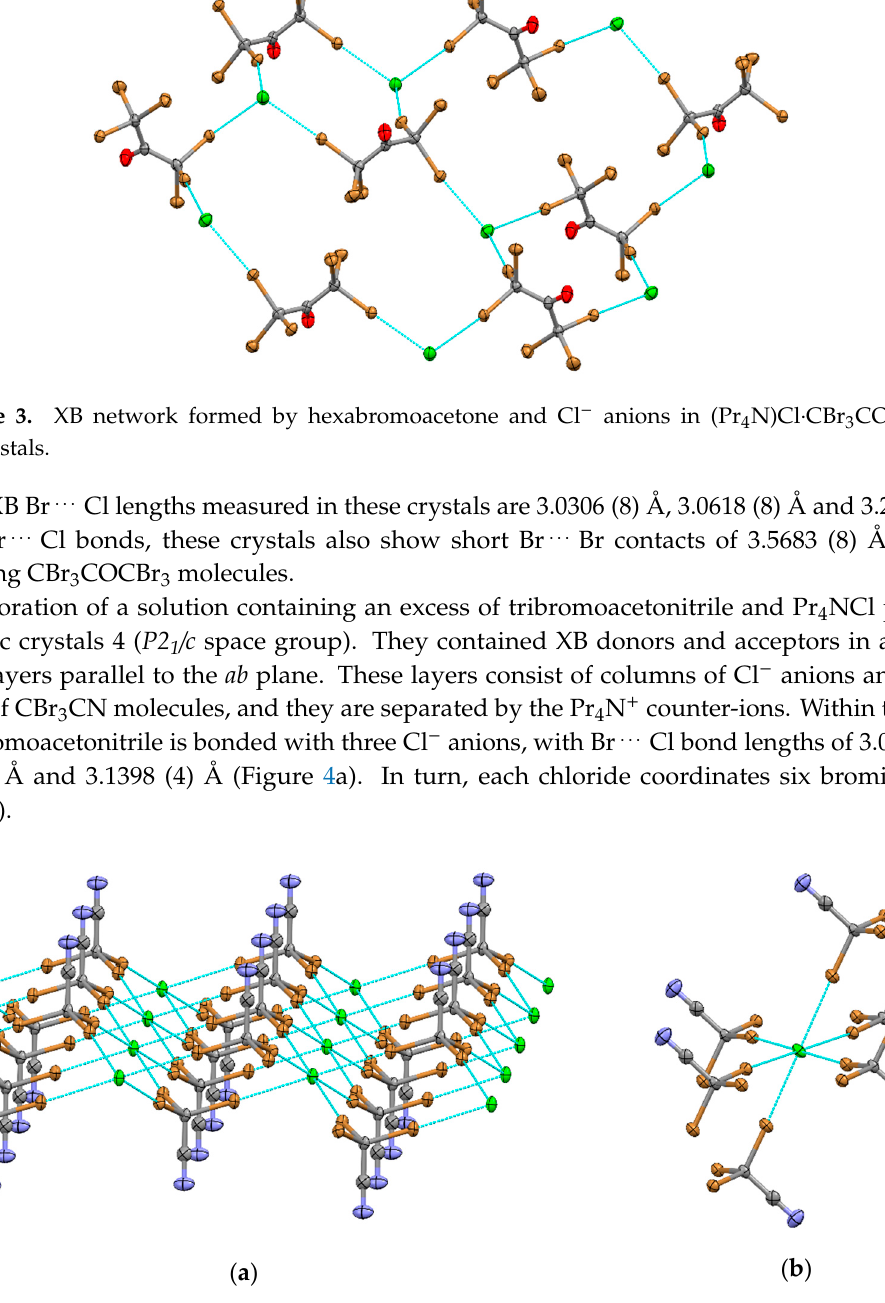
Figure 4. ( a ) XB networks formed by tribromoacetonitrile and chloride anions in (Pr 4 N)Cl · CBr 3 CN co-crystals 4. ( b ) Fragment of the X-ray structure of co-crystals 4 showing a (hexacoordinated) Cl − anion bonded with six CBr 3 CN molecules.